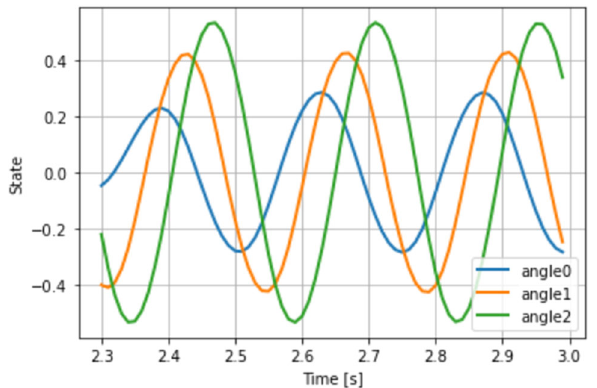
Fig. 11 Output angle of each joint obtained by proposed CPG model with parameters of solution 2